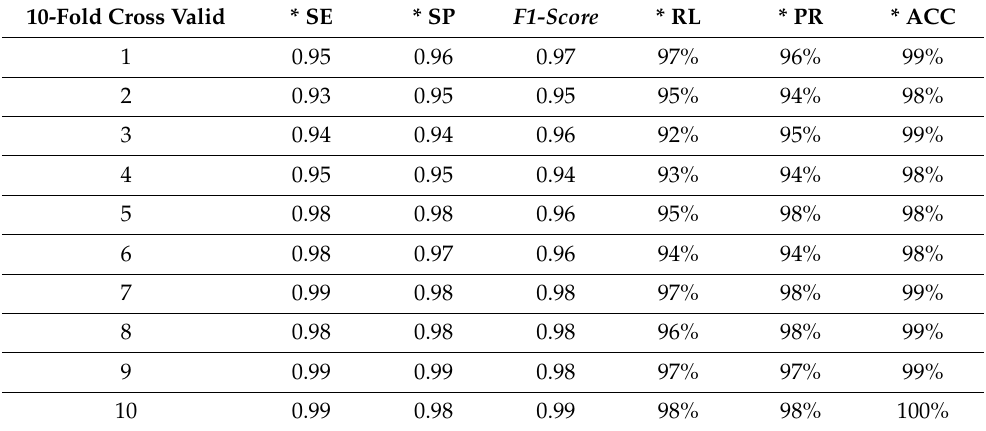
Table 4. Classification results of the Proposed Model by using data augmentation, 10-fold cross validation test and by using two stages of cardiovascular disease. 10-Fold Cross